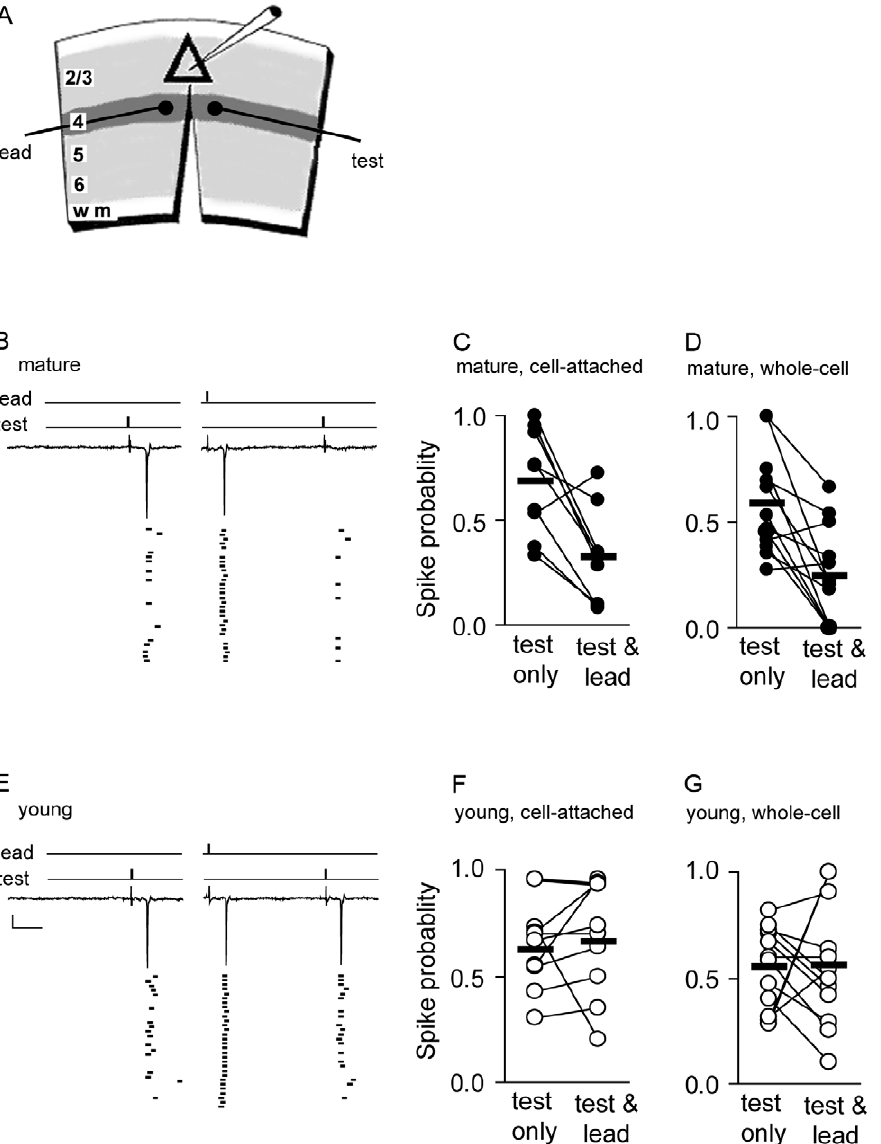
Figure 7. The potency of one input pathway to suppress the probability of a convergent pathway from triggering a postsynaptic spike in layer2/3 pyramidal neurons in V1 is developmentally regulated. (A) An experimental paradigm in visual cortical slices to examine the interaction of two convergent input pathways to drive postsynaptic spiking at layer 4 R layer 2/3 connections. Triangle represents a layer2/3 pyramidal soma. Field stimulation sites for the lead and test pathways are depicted. The slice is cut between the stimulation sites to ensure that the two pathways are independent. The ability of P lead to suppress threshold stimulation of P test was assayed in both cell attached mode and whole-cell mode in mature (B–D) and young (E–G) slices in the presence of APV and CGP55845. (B,E) Example traces of cell-attached recordings with inter-leaved trials in response to pathway stimulation. Stimulus artifacts were clipped. Action potentials were detected as a capacitive transient, approximately 500–600 pA in amplitude. Raster plots of spike events are aligned to onset of P lead stimulation. 30 trials are displayed, 30–60 trails were collected for each cell. Spike probability was assayed from 2 to 10 ms following stimulation of the P test during the Lead-Test trial,scale bar: 100 pA,10 ms. (B–D) Spike probabilities of each cell during Test Only and Test-Lead trial stimulations are shown for cell-attached (C; n=9), and whole-cell (D; n=12) recordings from mature visual cortical slices (P26–30), mean probability (black bar). (E–G) Same as in b-d except recordings were done in young slices (P16–18). Cell-attached, n=9, whole-cell, n=12. Note that P lead potently suppressed P test from driving postsynaptic spiking in mature but not young slices.